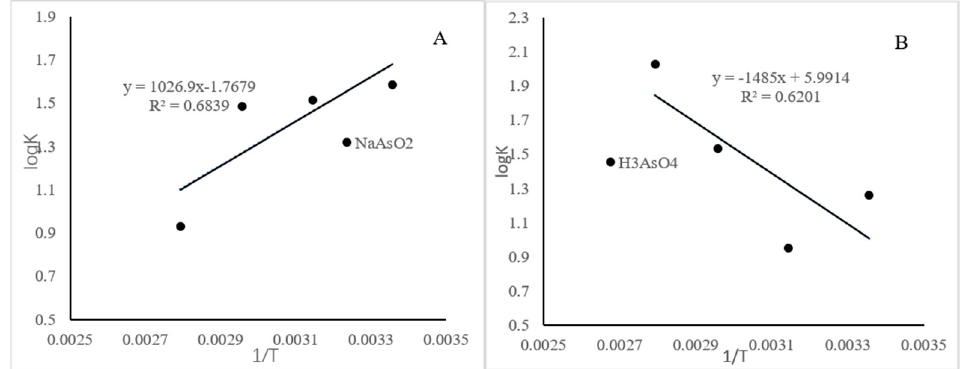
Figure 7. Regression curve of Langmuir model (( A ): NaAsO 2 ; ( B ): H 3 AsO 4 ).